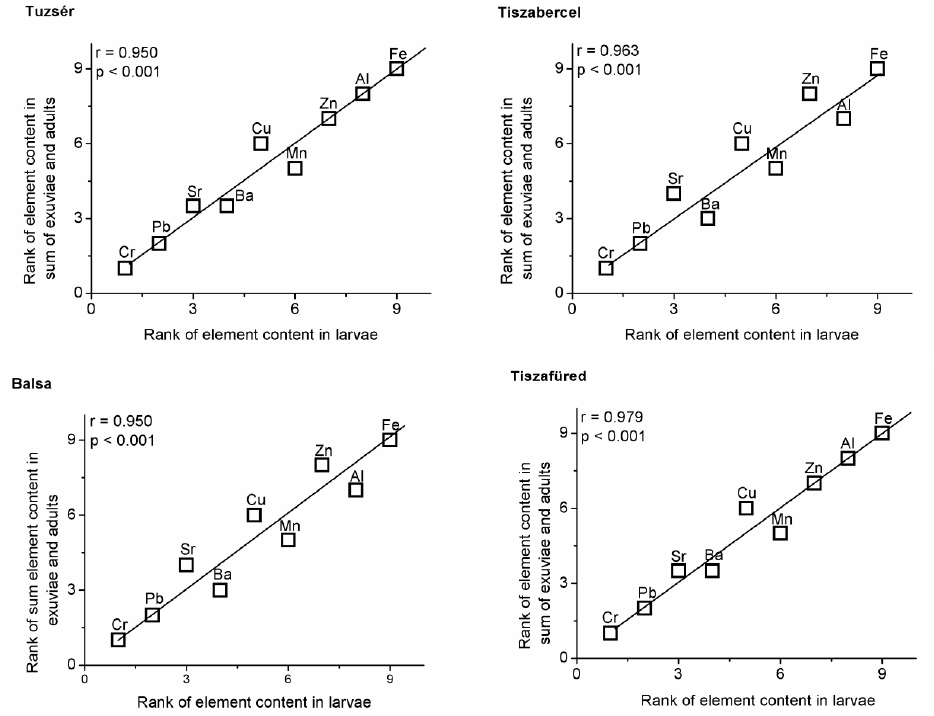
Figure 2. Pearson’s rank correlation between trace element content of larvae (element per individual, unit: µ g) and the sum of the trace element content (element per individual, unit: µ g) in exuviae and adults.